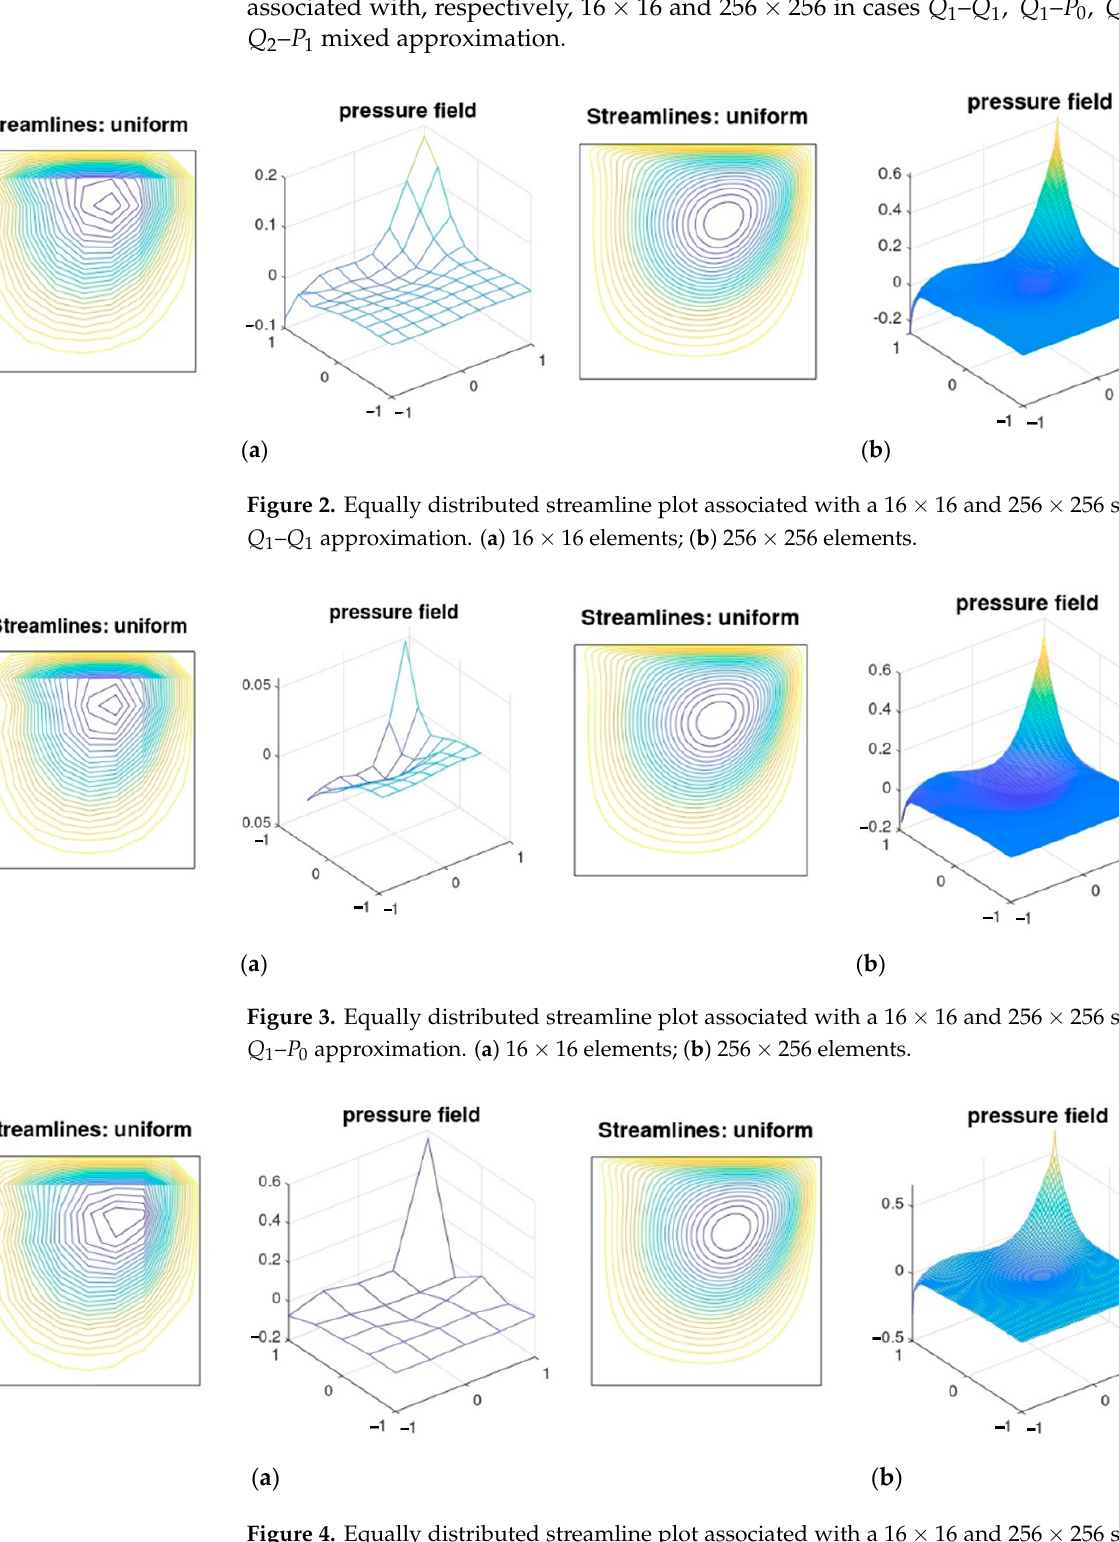
( b ) Figure 5. Equally distributed streamline plot associated with a 16 × 16 and 256 × 256 square grid, 𝑄 (cid:2870) – 𝑃 (cid:2869) approximation. ( a ) 16 × 16 elements; ( b ) 256 × 256 elements. Figures 6–9 represent the errors, associated with a 16 × 16 and a 256 × 256 uni- form square grid with a di ff erent element, 𝑄 (cid:2869) – 𝑄 (cid:2869) , 𝑄 (cid:2869) – 𝑃 (cid:2868) , 𝑄 (cid:2870) – 𝑄 (cid:2869) , and 𝑄 (cid:2870) – 𝑃 (cid:2869) . ( a ) ( b ) Figure 6. Error associated with a 16 × 16 and a 256 × 256 square grid, 𝑄 (cid:2869) – 𝑄 (cid:2869) approximation. ( a ) 16 × 16 elements; ( b ) 256 × 256 elements.